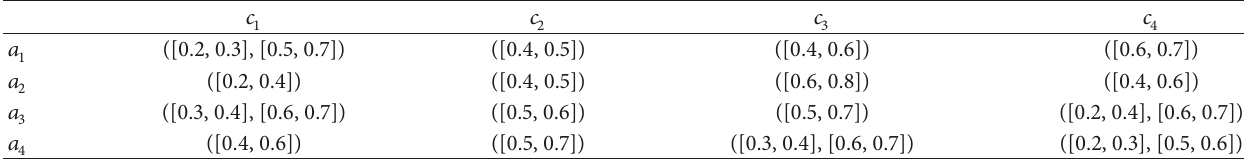
Table 1: The interval-valued hesitant fuzzy matrix 𝐴 1 .